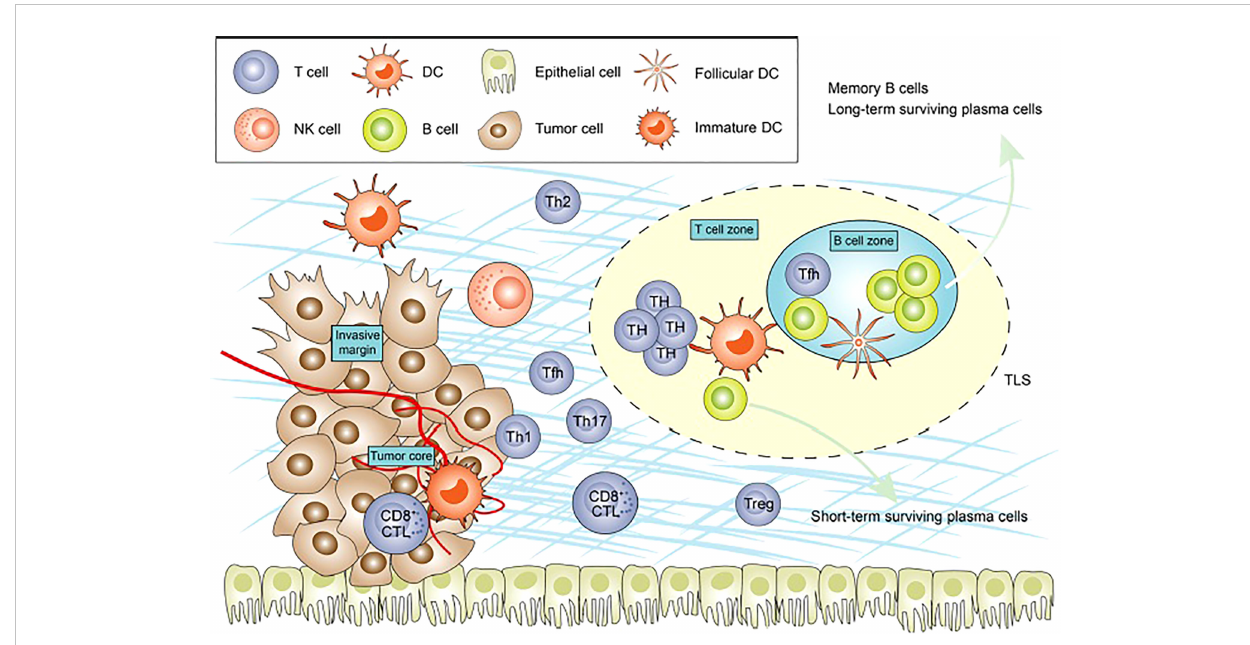
FIGURE 1 Figure adapted from recent Frontiers publication by Bai et al. demonstrating the cellular composition of the tumor